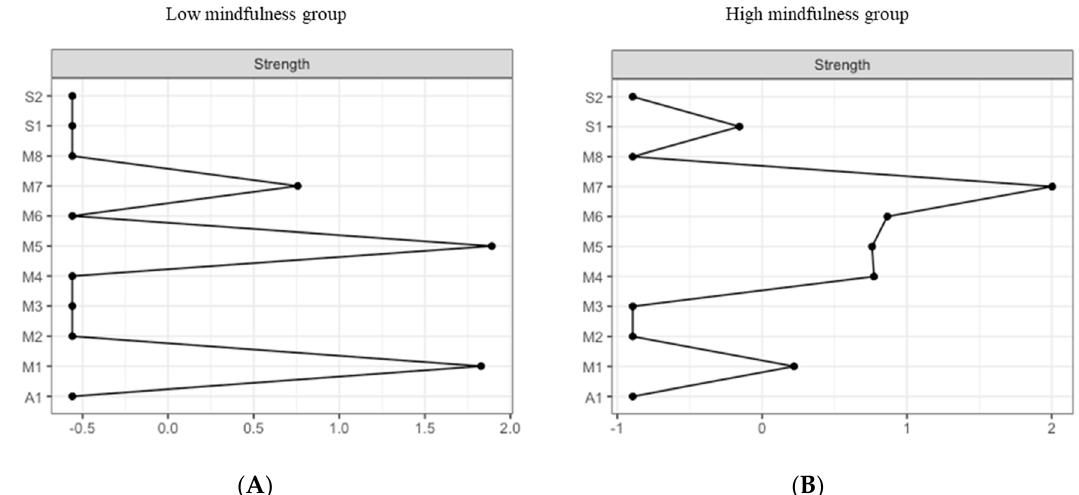
Figure 9. Estimated edge-weights for the estimated network and centrality of nodes. Centrality of nodes within a network according to low MD profile ( A left) and the high MD profile ( B right). S1: SPANE positive emotion; S2: SPANE negative emotion; F1: FMI presence; F2: FMI Non-judgmental acceptation; M1: MAIA noticing; M2: MAIA not distracting; M3: MAIA not worrying; M4: MAIA attention regulation; M5: MAIA emotional awareness; M6: MAIA self-regulation; M7: MAIA body listening; M8: MAIA trusting; A1: Subjective olfactory acuity.